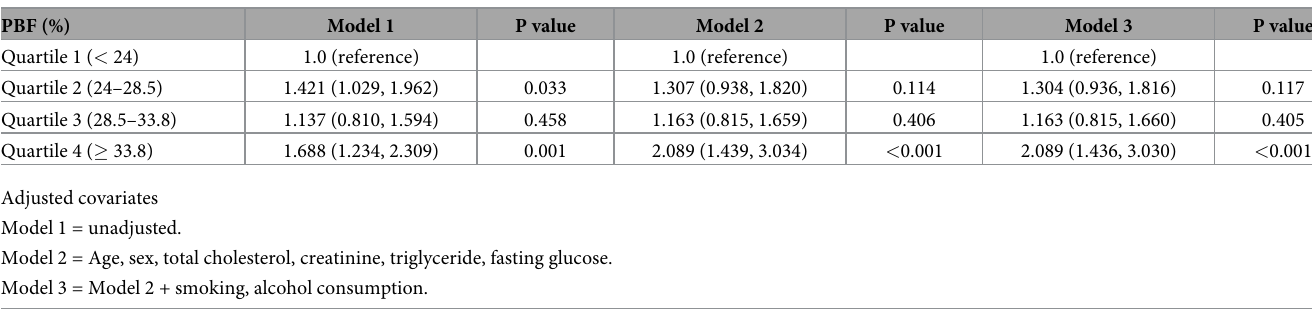
Table 5. Risks of diverticulosis by quartile of percentage of body fat.